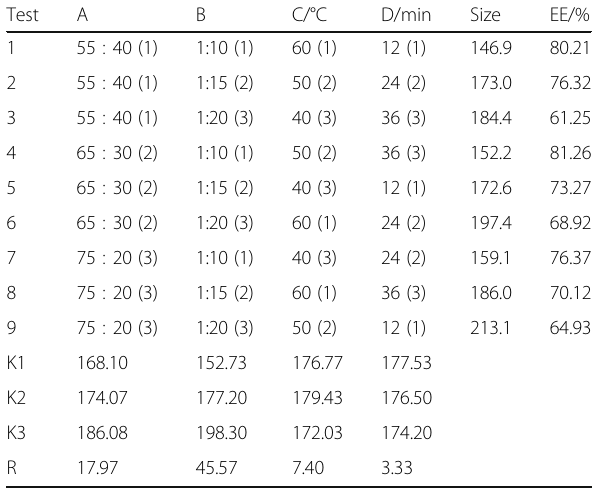
Table 3 Results of the orthogonal-design L 9 (3 4 ) test Test